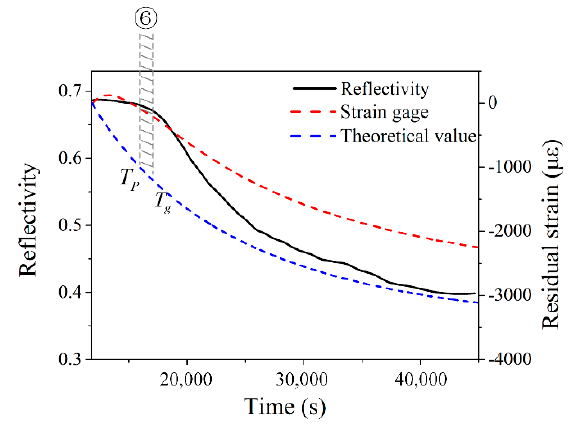
Figure 15. Reflectivity change compared with internal strain.